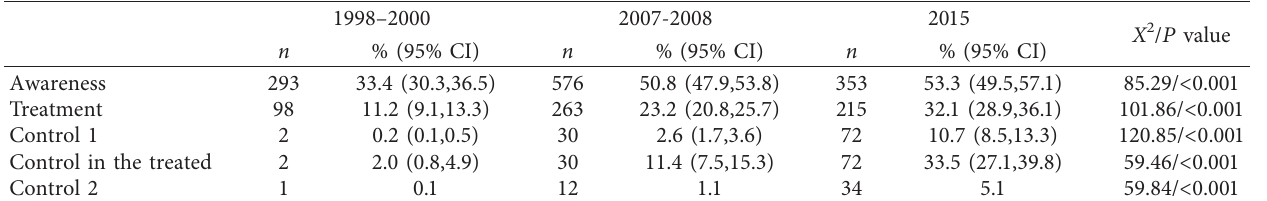
Table 2: Changes in awareness, treatment, and control of hypertension between 1998 and 2015 ( n , %).